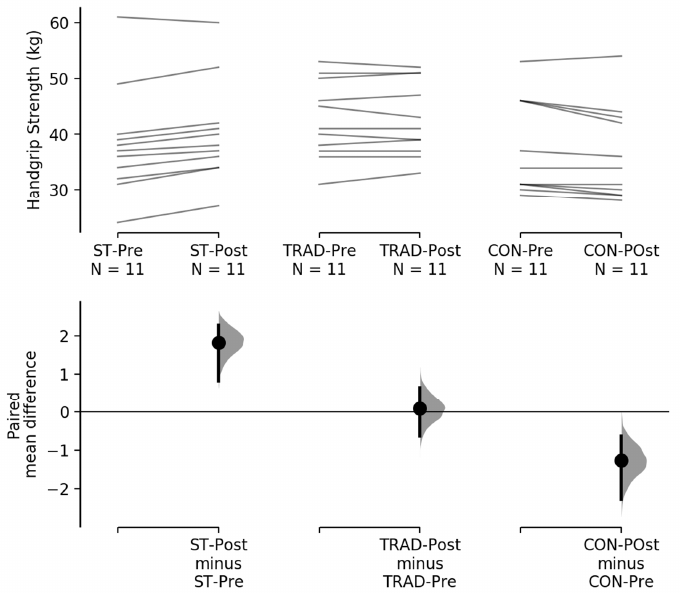
Figure 5. The paired mean difference for 3 comparisons are shown in the above Cumming estimation plot [42]. The raw data are plotted on the upper axes; each paired set of observations is connected by a line. On the lower axes, each paired mean difference is plotted as a bootstrap sampling distribution. Mean differences are depicted as dots; 95% confidence intervals are indicated by the ends of the vertical error bars.